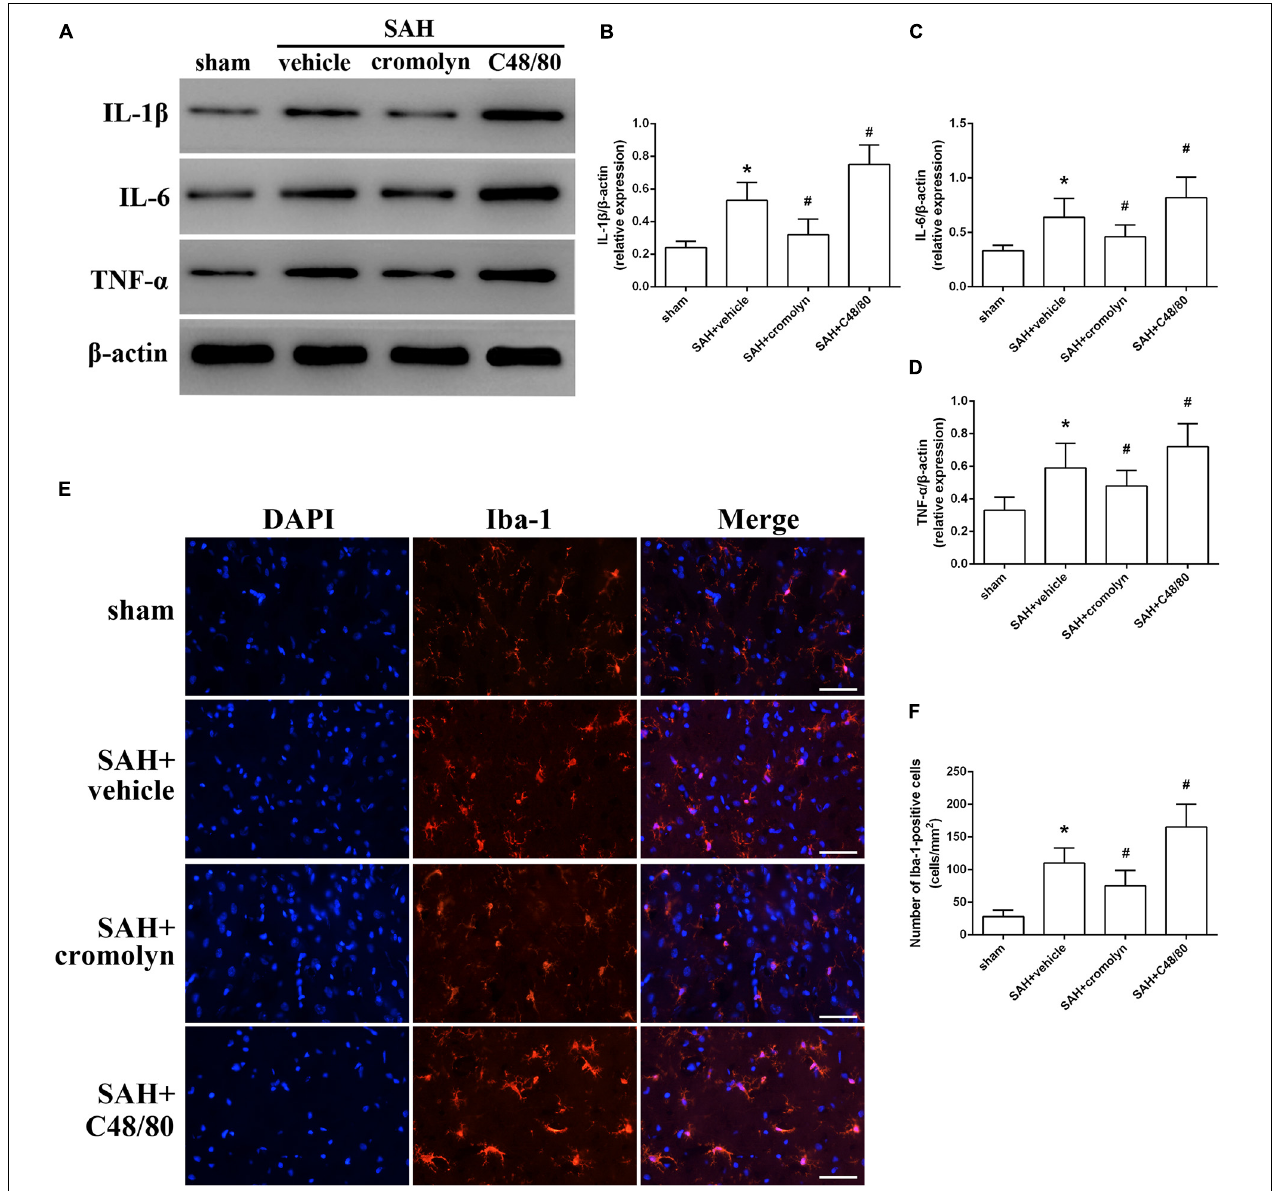
FIGURE 4 | Effect of MCs on SAH-induced neuroinflammation at 24 h post-modeling. (A–D) Representative picture and quantitative analysis of expression of TNF- α , IL-1 β , and IL-6 in different groups. (E,F) Representative picture and quantitative analysis of microglia activation in ipsilateral basal cortex after SAH. scale bar = 50 µ m. n = 6. Data are represented as mean ± SD. * P < 0.05 versus sham group. # P < 0.05 versus SAH + vehicle